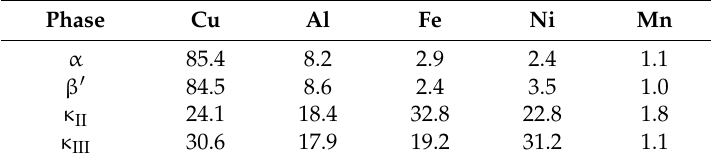
Table 1. Chemical compositions of each phase in the nickel-aluminum bronze (NAB) alloy (wt %).